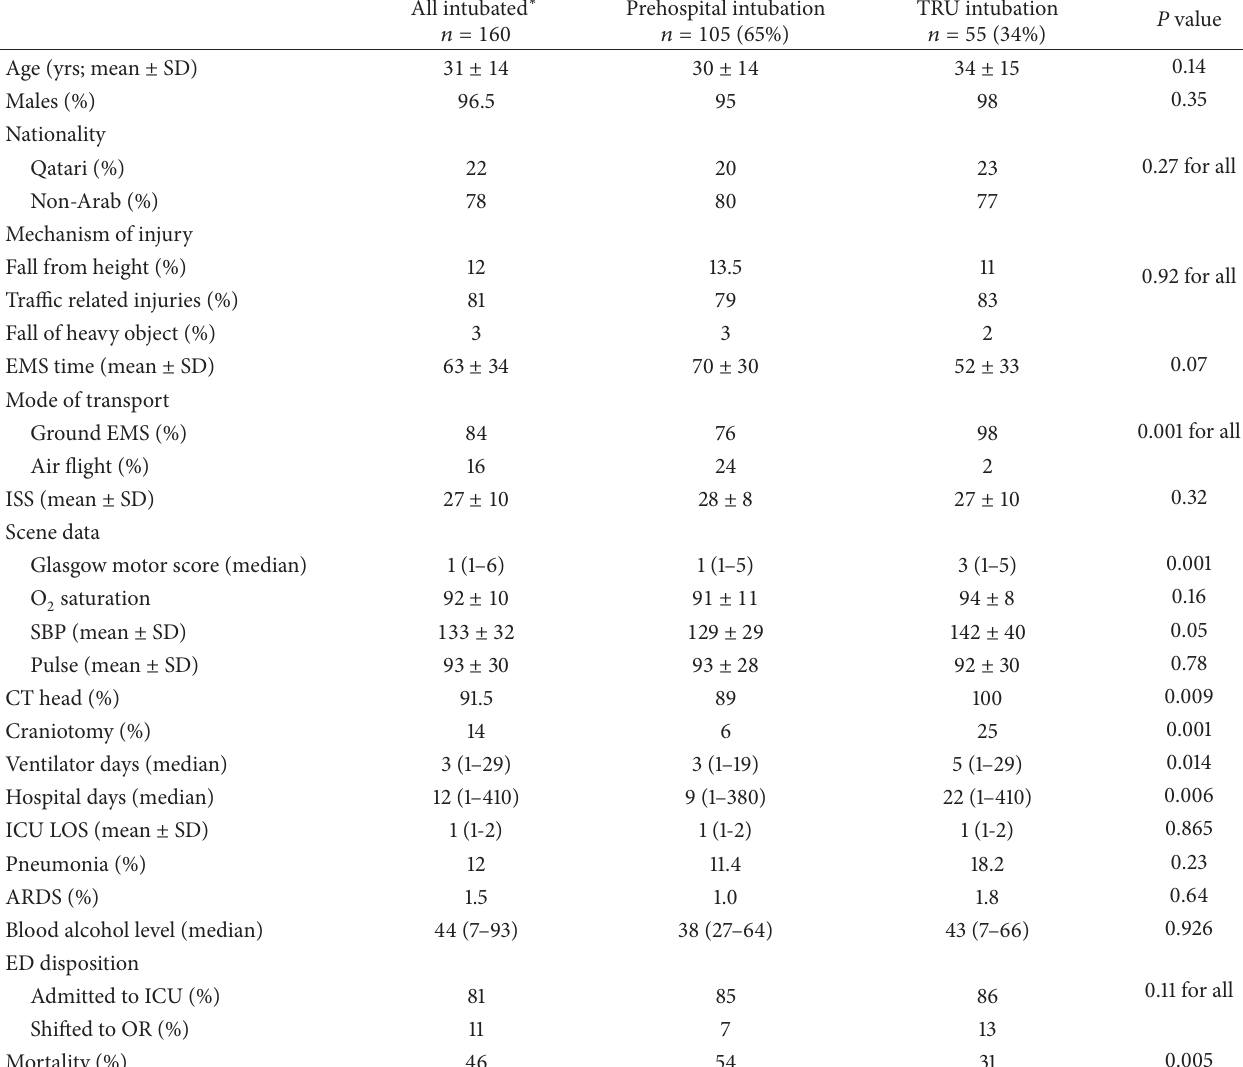
Table 1: Demographics of all intubated isolated severe traumatic brain injury cases.